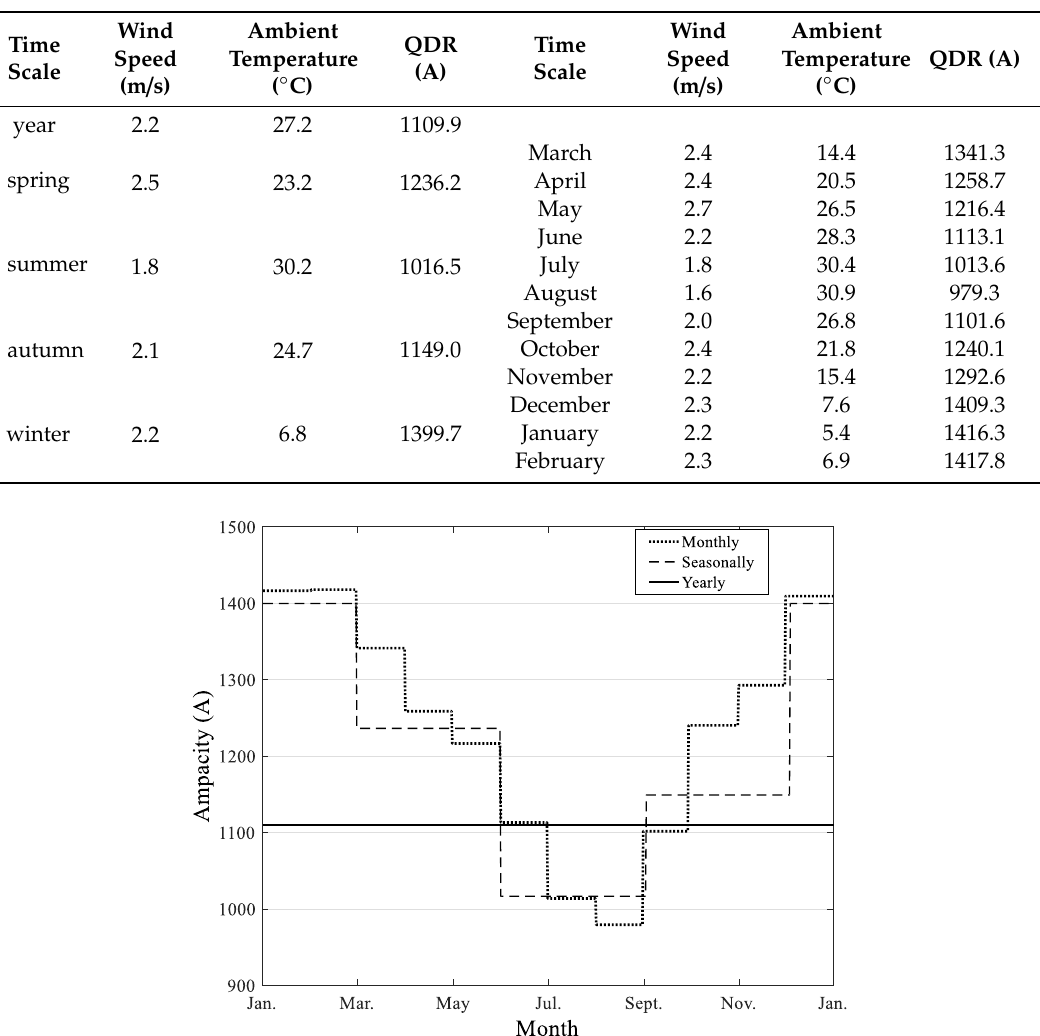
Figure 4. The results of quasi-dynamic thermal ratings under confidence level of 95%.